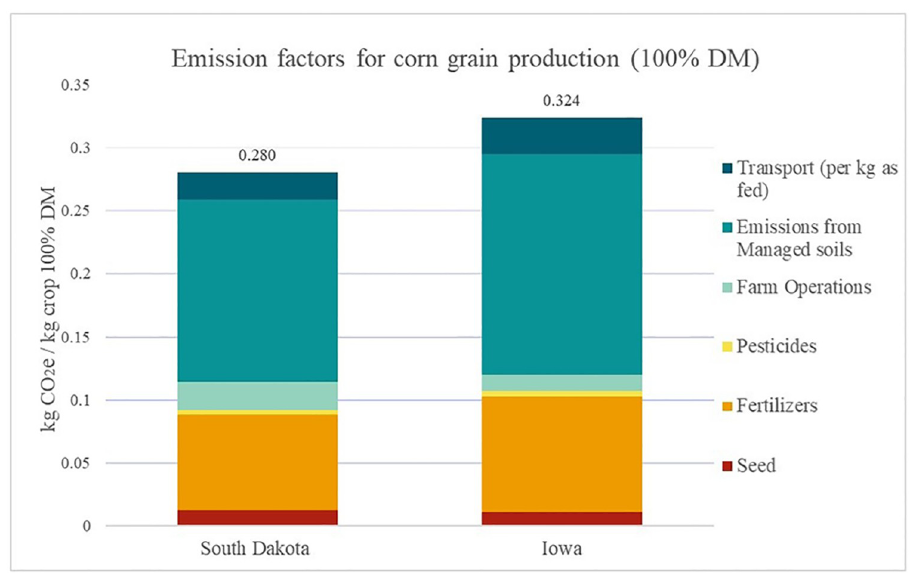
Fig 3. Comparison of emissions related to corn grain production at the farm gate in South Dakota and